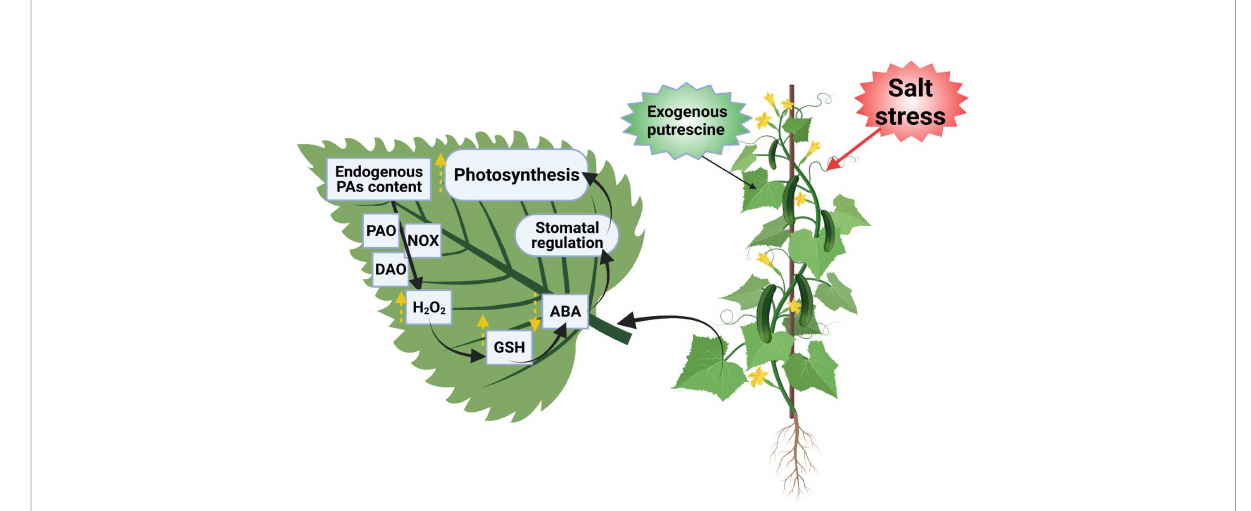
FIGURE 5 The model diagram of exogenous Put effects on the photosynthesis of cucumber leaves under salt stress. It regulates the stomatal opening and closing, where: Put-putrescine, PAs-polyamines, DAO-diamine oxidase, PAO-polyamine oxidase, NOX-nicotinamide adenine dinucleotide phosphate oxidase, H 2 O 2 -hydrogen peroxide, GSH-reduced glutathione, ABA-abscisic acid (Ma et al., 2020).